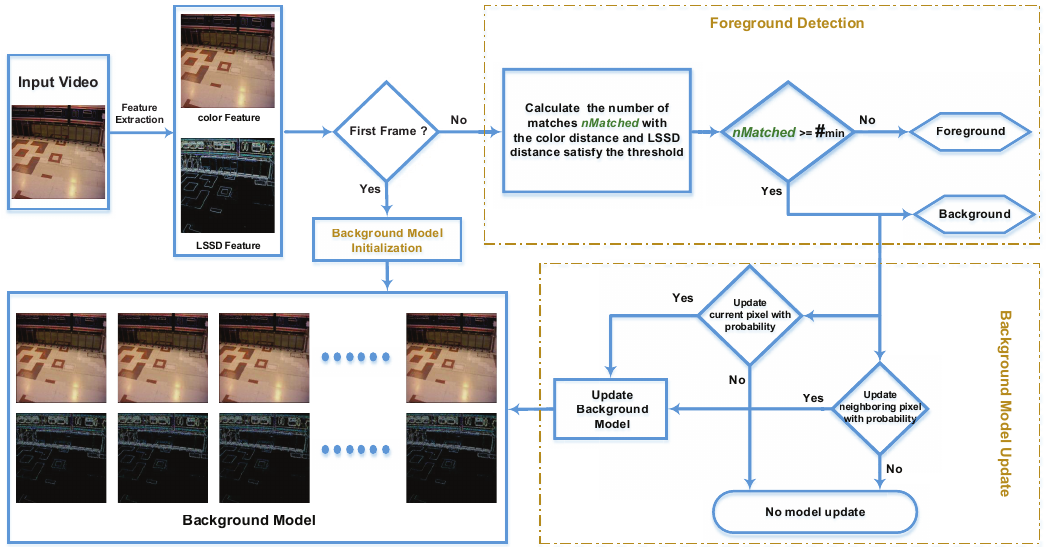
Figure 6. Flow chart of the proposed background subtraction